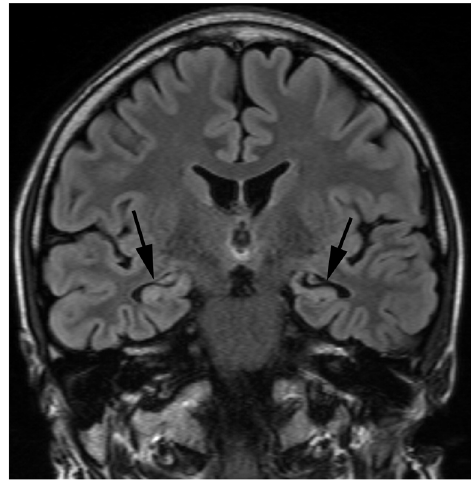
Fig. 8 Hippocampal sclerosis. A 24-year-old-man, who received bone marrow transplantation for malignant lymphoma at the age of six, presented with temporal lobe epilepsy. FLAIR image shows atrophy with high signal intensity in the bilateral amygdalae and hippocampi ( arrows